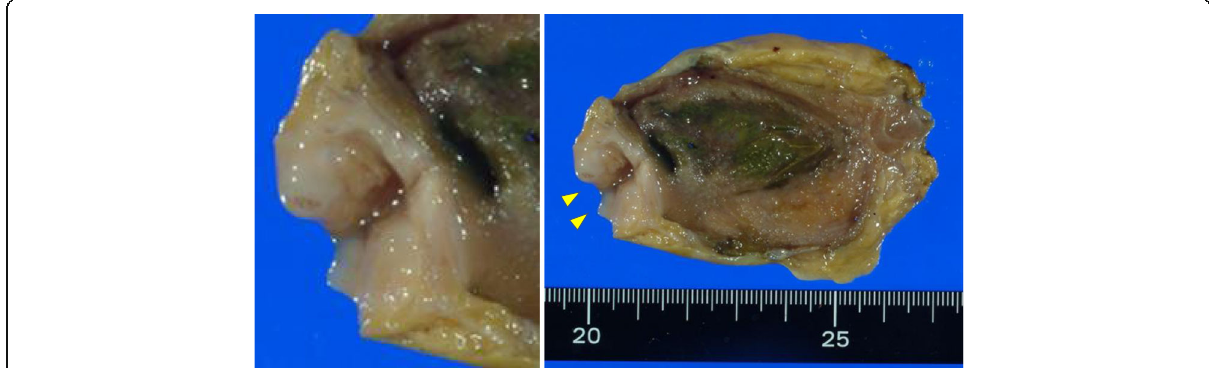
Fig. 2 Photograph of resected specimen. It shows the gallbladder fundus on the left side and the cystic duct on the right side. A 15 × 10-mm mass like a submucosal tumor is visible within the gallbladder fundus (arrow), and its cut surface shows the papillary